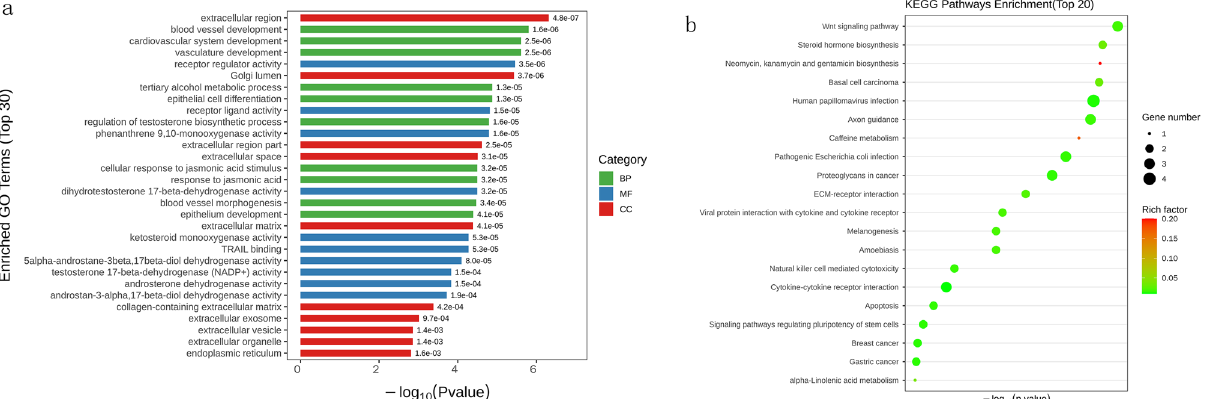
Figure 5. ( a ) Gene Ontology analysis of differentially expressed genes (DEGs) altered by isorhamnetin (ISO). The y-axis shows the GO term, and the x-axis shows the − log10 ( p value). ( b ) Kyoto Encyclopedia of Genes and Genomes (KEGG) enrichment bubble map of DEGs altered by ISO. The y-axis shows the pathway name, and the x-axis shows the corresponding p value of the pathway. The rich factor is the number of DEGs/the total number of genes detected in the